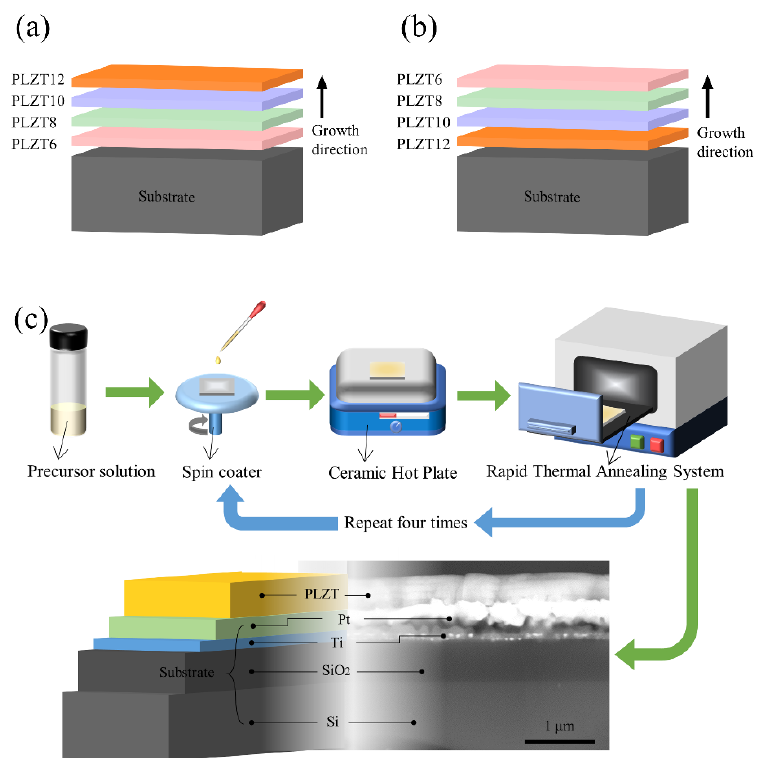
Figure 1. Schematic of the ( a ) up-graded and ( b ) down-graded multilayer ferroelectric thin film. ( c ) Process of fabricating the ferroelectric thin